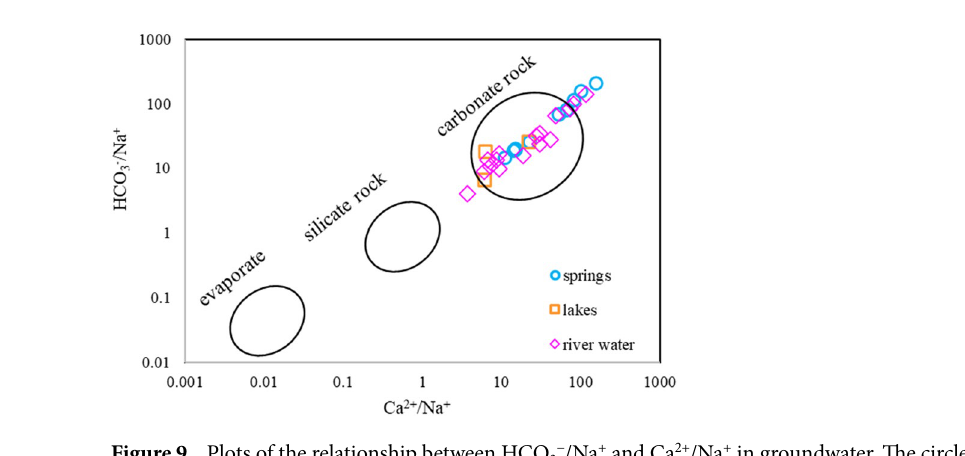
Figure 9. Plots of the relationship between HCO 3− /Na + and Ca 2+ /Na + in groundwater. The circles and ellipses are schematic representations of typical water–rock